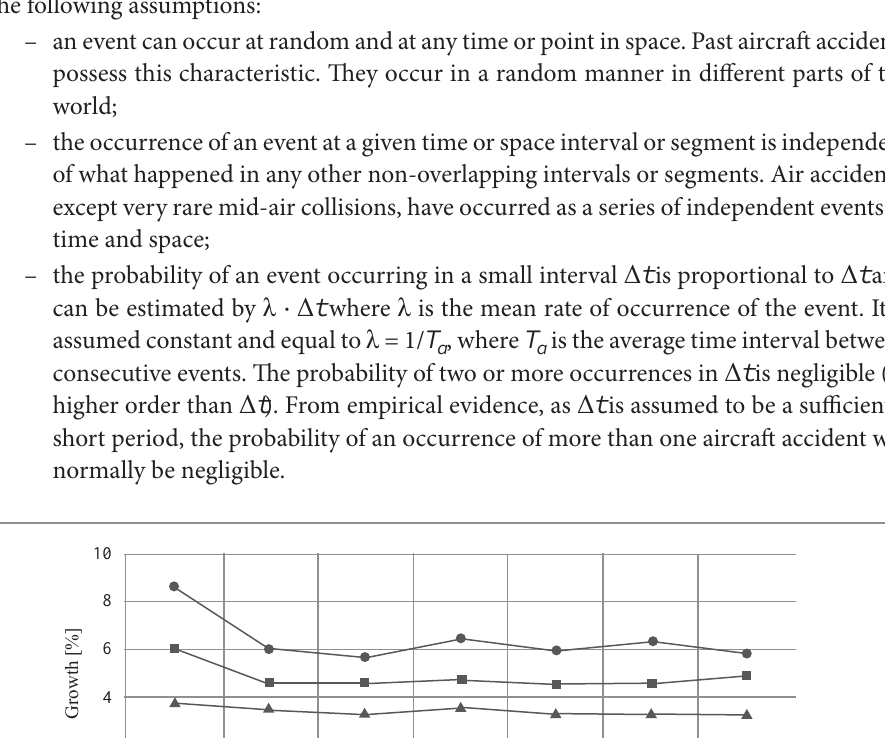
Baseline scenarioHigh scenario Low